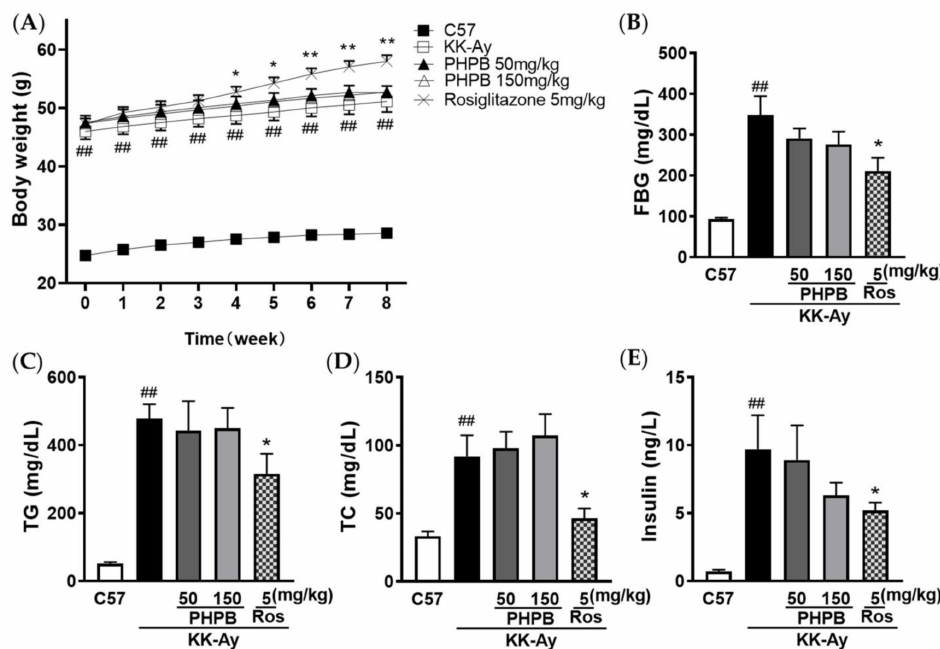
Figure 2. Effects of PHPB on body weight and metabolic features in mice. KK-Ay mice were treated with PHPB (50 or 150 mg/kg) or rosiglitazone (5 mg/kg) for two months by oral gavage. ( A ) Body weight, ( B ) Fasting blood glucose (FBG), ( C ) Plasma triglycerides (TG), ( D ) Plasma total cholesterol (TC), and ( E ) Plasma insulin. Values are represented as mean ± SEM. n = 10 for C57 group, n = 19 for KK-Ay group, n = 17 for PHPB 50 mg/kg group, n = 17 for PHPB 100 mg/kg group, n = 16 for rosiglitazone group. ## p < 0.01 versus C57 group; * p < 0.05, ** p < 0.01 versus KK-Ay